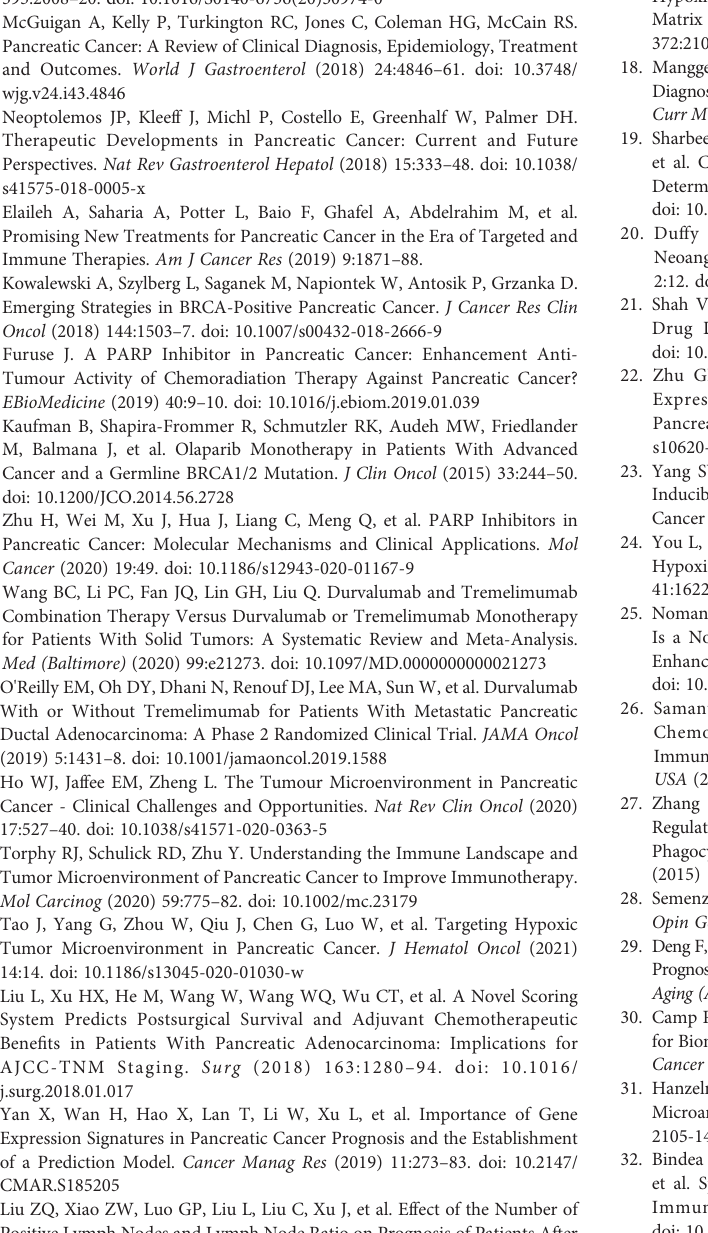
Supplementary Figure 1 | (A) Differential expression analysis of the 16 HIF-1 related genes between non-tumor and tumor samples. (B) Forest plots to show the results of KM survival analysis of the 16 HIF-1 related genes. KM, Kaplan-Meier. **P value < 0.01; ***P value < 0.001; ****P value < 0.0001. Supplementary Figure 2 | (A) Differential expression analysis between HIF-1 cluster (A, B) . (B) Differential expression analysis between HIF-1 cluster (A, C) . (C) Differential expression analysis between HIF-1 cluster (B, C) . (D) Intersection of differential expressed genes among these three HIF-1 clusters.